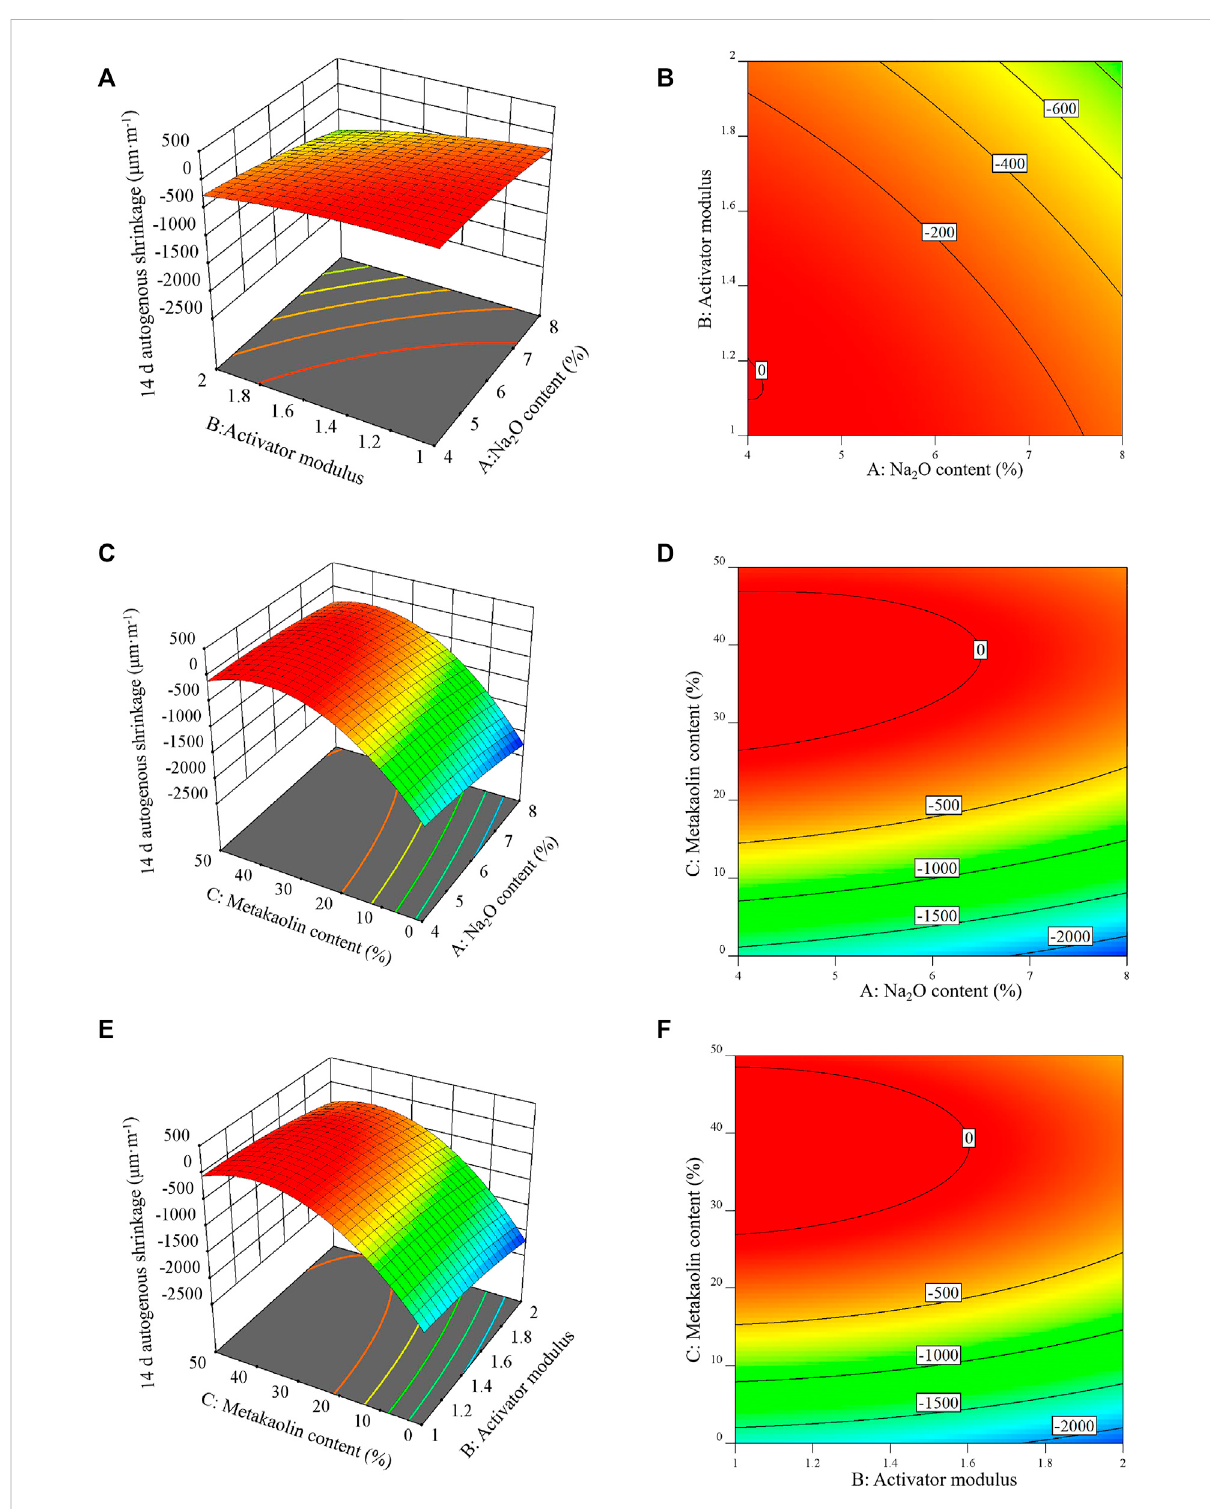
FIGURE 6 3D response surface diagrams of autogenous shrinkage of